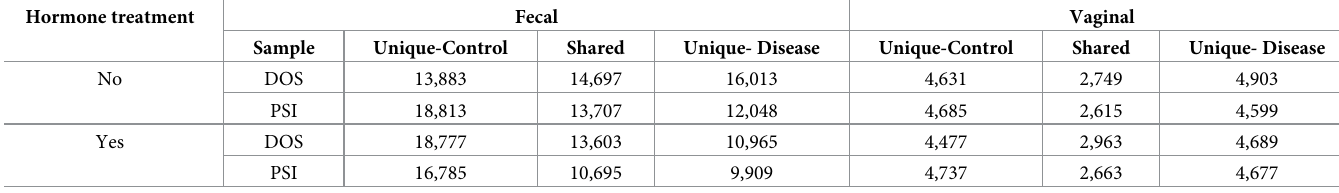
Table 3. Comparison of fecal and vaginal phylotypes samples between controls and patients with endometriosis. Hormone treatment Fecal